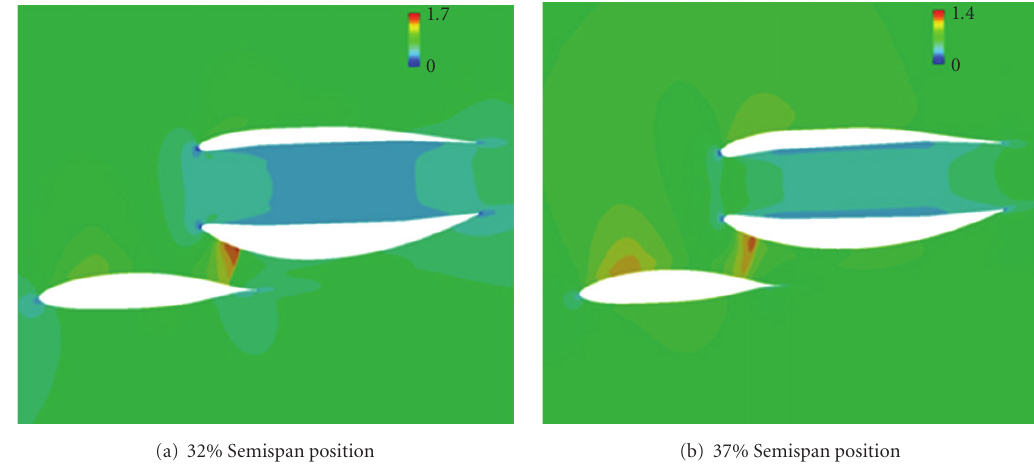
Figure 15: Cp distribution of OPT1